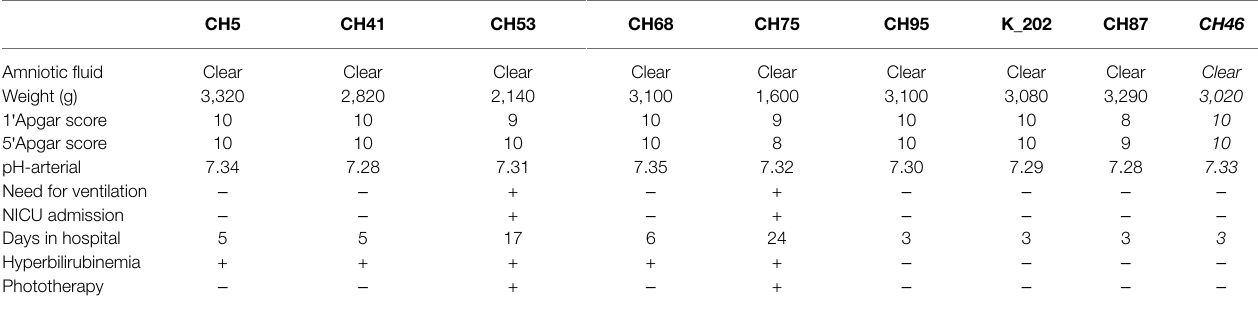
TABLE 2B | Clinical characteristics of neonates born to PI*MZ and PI*MS (highlighted in italics) heterozygous mothers with recent history of ICP (see Table 2A